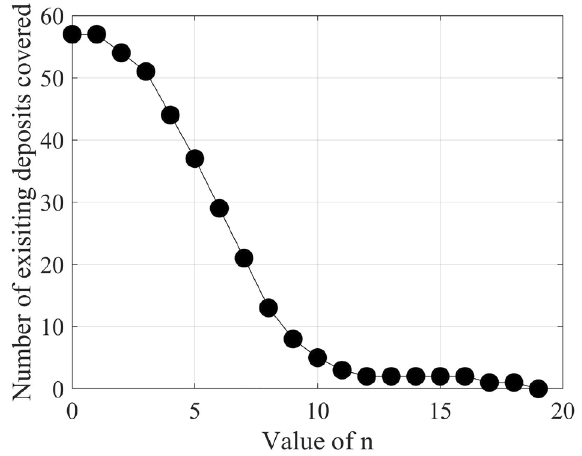
Figure 14. Change in the number of existing petroleum deposits covered by n-vote instances with an increasing value of n for the new test dataset from